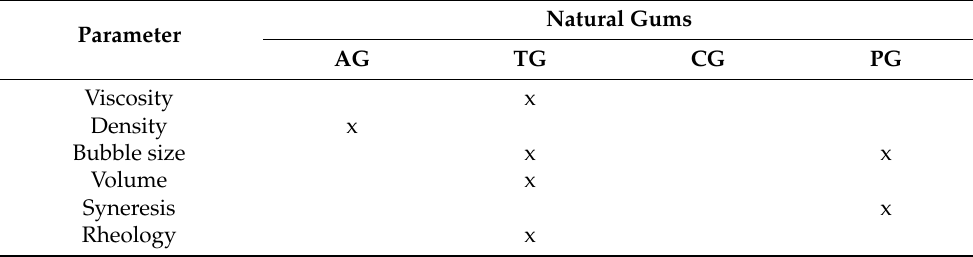
Table 5. Summary of measured parameters in which the gums have played a relevant stabilizing function considering the significant